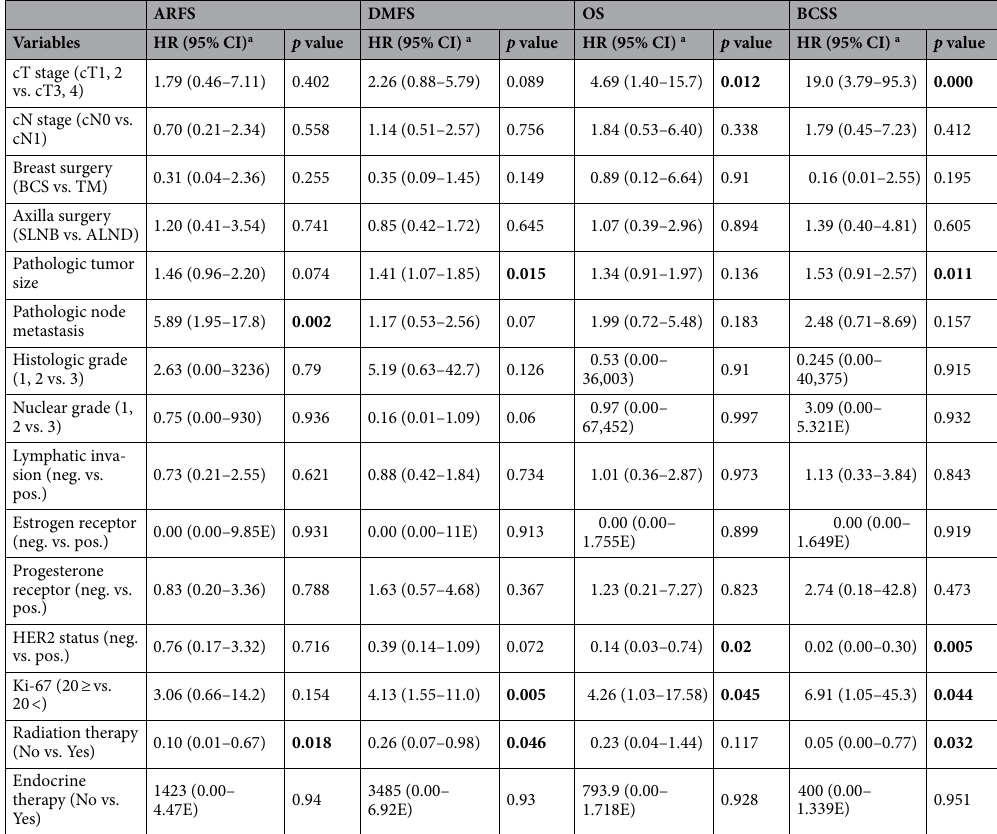
Table 5. Multivariate Cox regression analysis after propensity score matching. ARFS, axillary recurrence-free survival; DMFS, distant metastasis-free survival; OS, overall survival; BCSS, breast cancer-specific survival; BCS, breast conserving surgery; TM, total mastectomy; SLNB, sentinel lymph node biopsy; ALND, axillary lymph node dissection. Bold values indicate statistically significant p -value less than